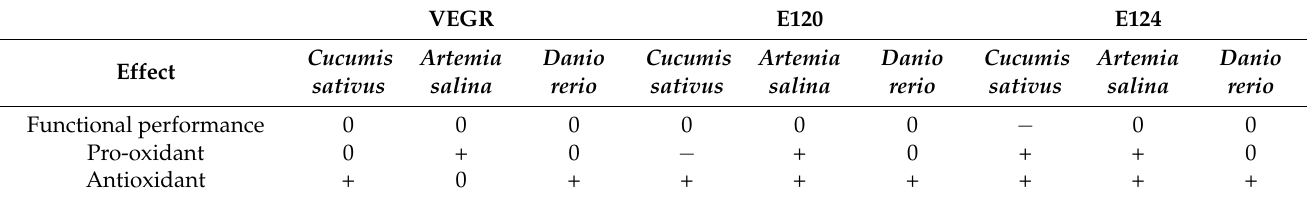
Table 2. Qualitative synthesis of the effects of E124, E120, and VEGR on the functional performance (oxygen consumption, in all three species, or photosynthetic system, in C. sativus , leaves, root or both), pro-oxidant levels (H 2 O 2 levels, in C. sativus , leaves, root or both, or Total ROS levels, in A. salina and D. rerio ), and antioxidant activity (total antioxidant activity and/or polyphenols, in C. sativus -leaves, root or both- or oxidative stress susceptibility in A. salina and D. rerio ). Note that an increased oxidative stress susceptibility implies a reduced antioxidant activity and vice versa [71]. The effects were classified as stimulatory (+), inhibitory ( − ), or no effect (0). VEGR E120